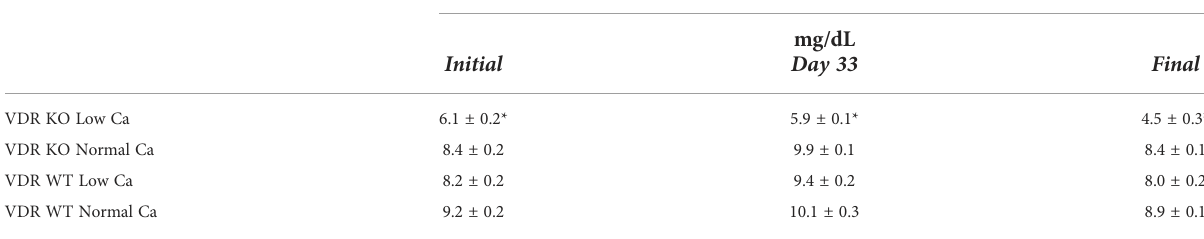
TABLE 2 Serum parameters in VDR knockout